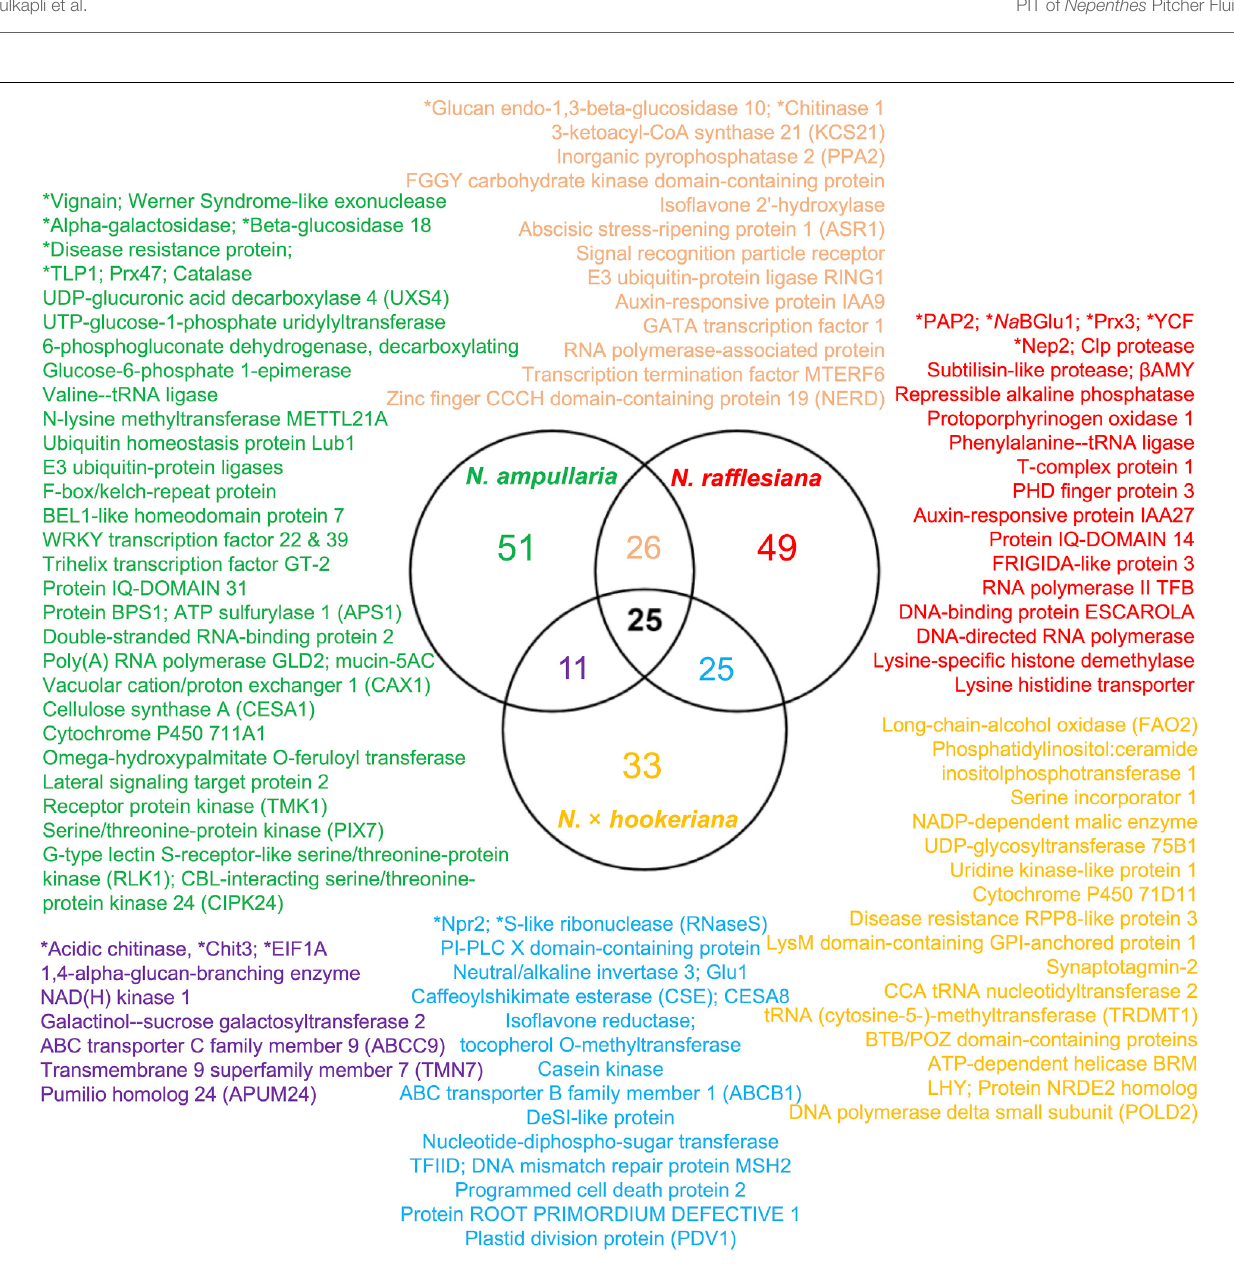
FIGURE 3 | Venn diagram analysis of proteins identified from proteomics analysis. Selected proteins for each intersection are listed according to the font colors. Asterisks ( ∗ ) indicate proteins reported previously in the pitcher fluids of other Nepenthes species. Refer to Supplementary File 3 for